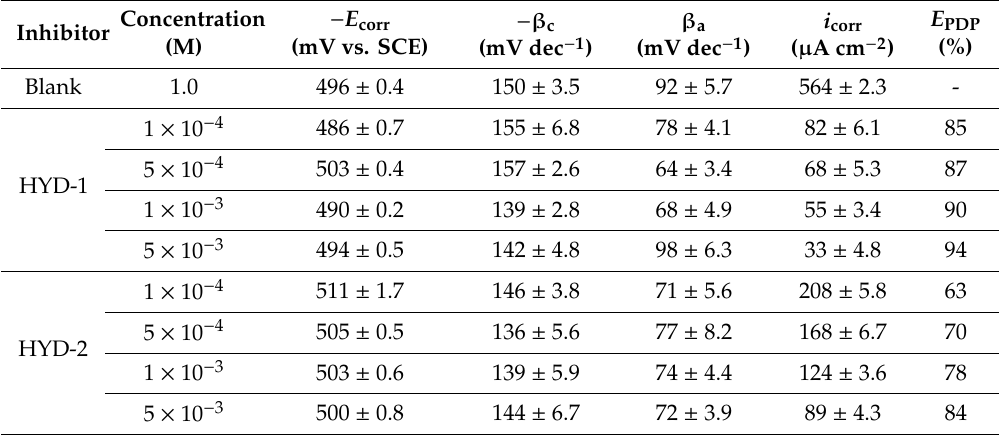
Table 3. Electrochemical parameters derived after extrapolating the inhibited and uninhibited polarization curves. Inhibitor Concentration (M)